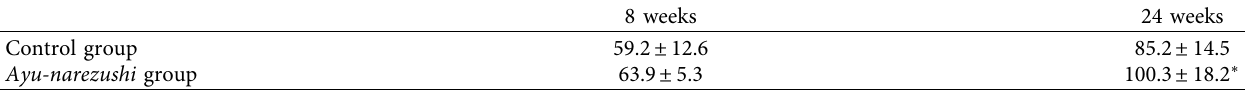
Table 2: Comparison of the mean number of visceral adipocytes between the ayu-narezushi and the control groups at 8 and 24weeks of age. 8 weeks 24 weeks Control group 59.2 ± 12.6 85.2 ± 14.5 Ayu-narezushi group 63.9 ± 5.3 100.3 ± 18.2 ∗